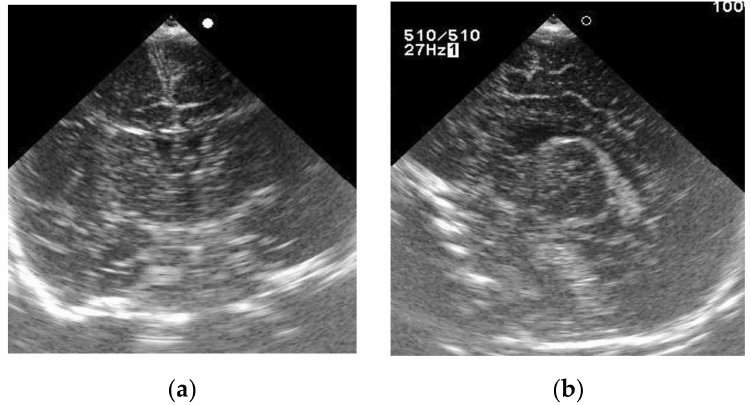
Figure 1. Brain ultrasonography of Case 2 at 13 days of age. ( a ) Coronal plane; ( b ) sagittal